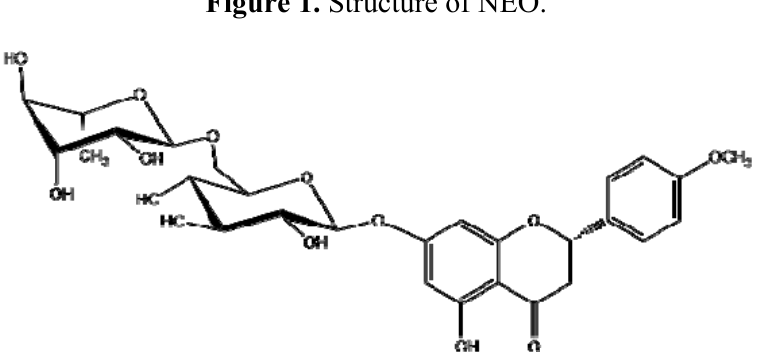
Figure 1. Structure of NEO.